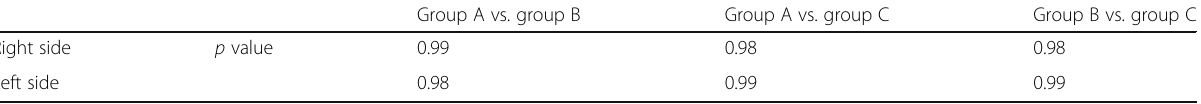
Table 3 Multiple pairwise comparison tests (post hoc tests) for the hand grip strength among different groups at both